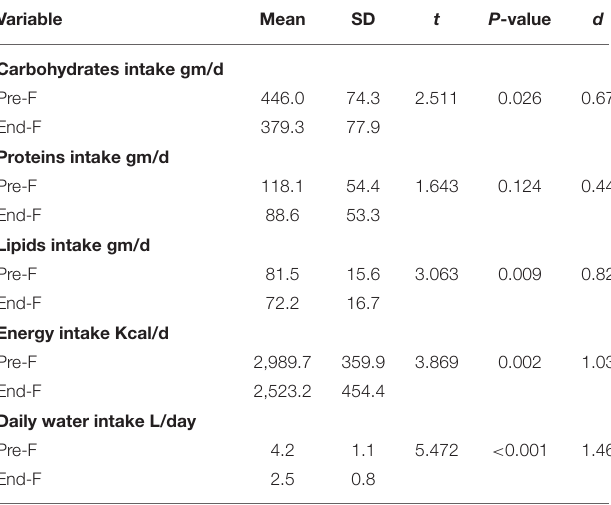
TABLE 2 | Assessment of changes in caloric, water, and macronutrients intake during Ramadan fasting.